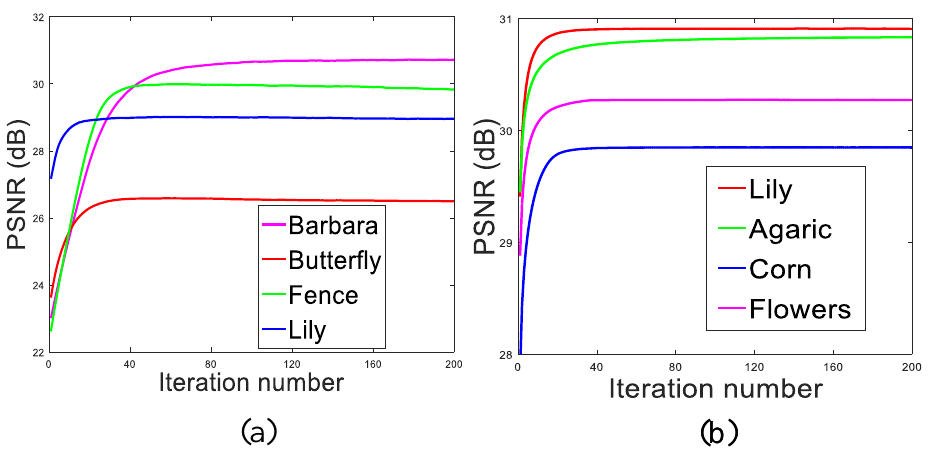
Figure 7. Convergence analysis of the proposed algorithm. ( a ) PSNR results versus iteration number for image inpainting with 80% pixels missing. ( b ) PSNR results versus iteration number for image deblurring with Gaussian kernel.